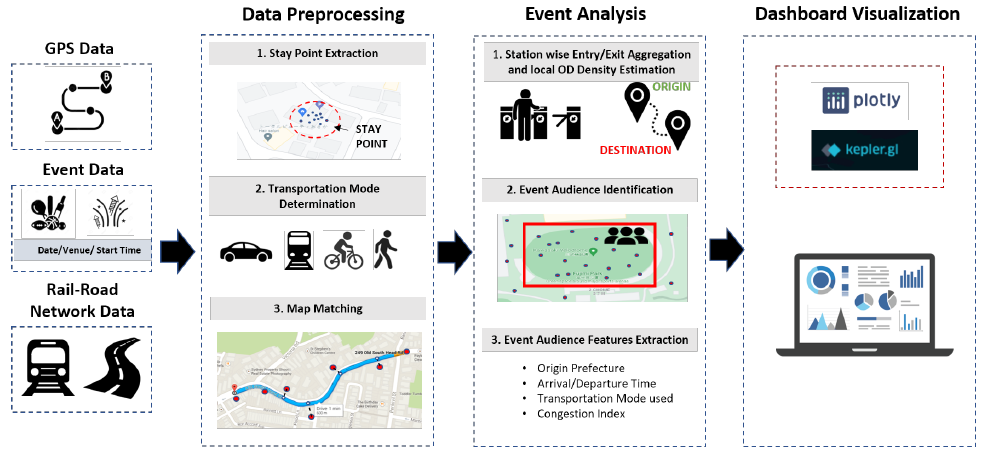
Figure 1. The System Framework of the